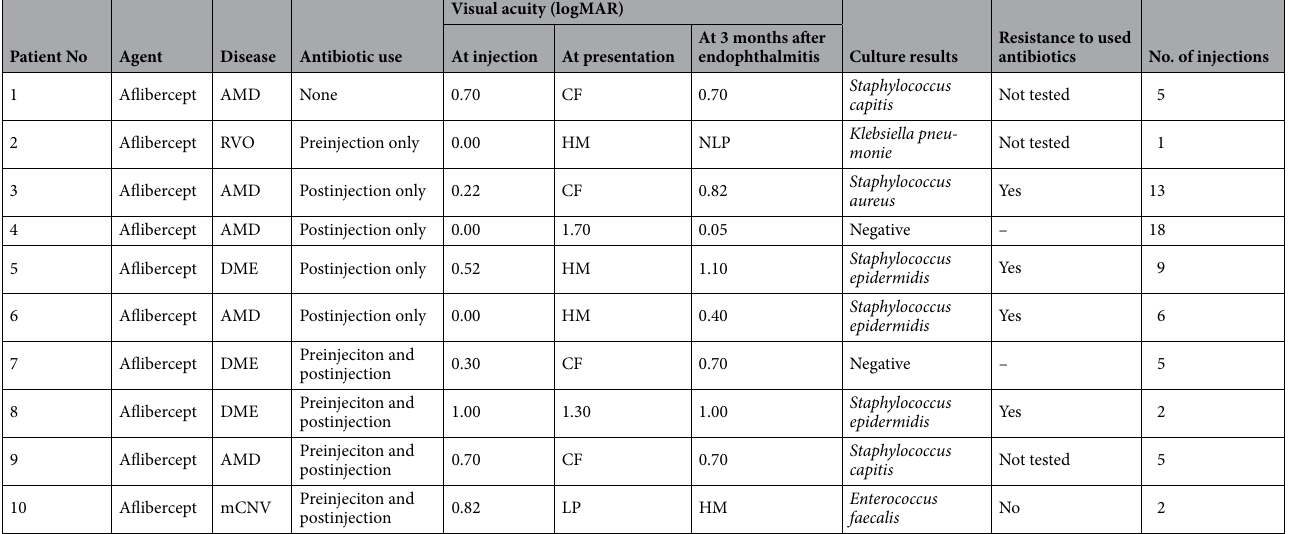
Table 4. The characteristics of the 10 patients who suffered from endophthalmitis. HM hand motion, CF counting finger, LP light perception, NLP no light